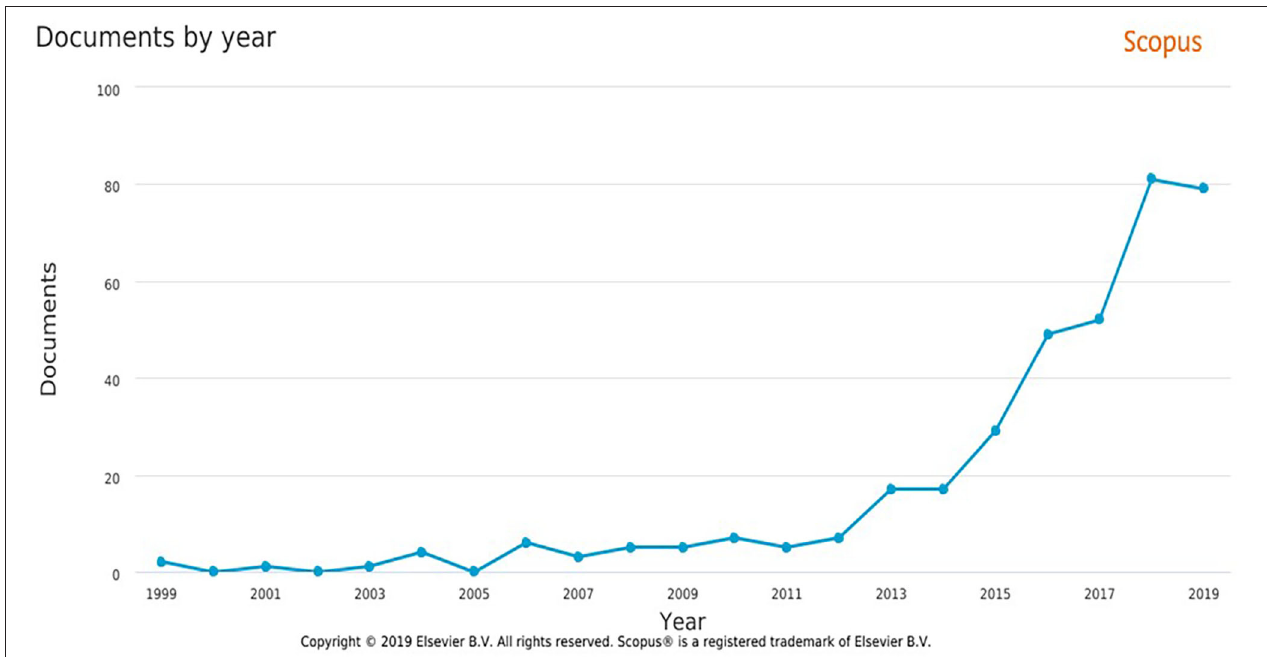
FIGURE 1 | Number of articles listed in Scopus that mention “rewilding” or “re-wilding.” The search led to 370